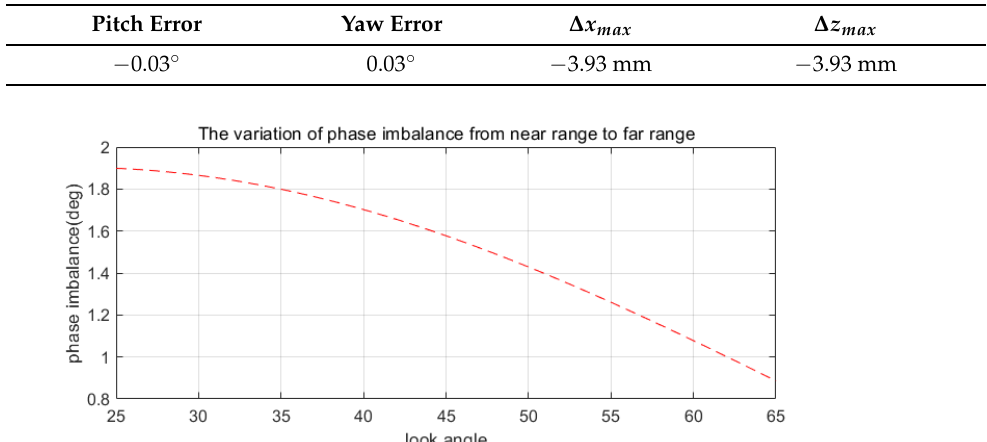
Table 2. The max attitude control errors of GF-3.